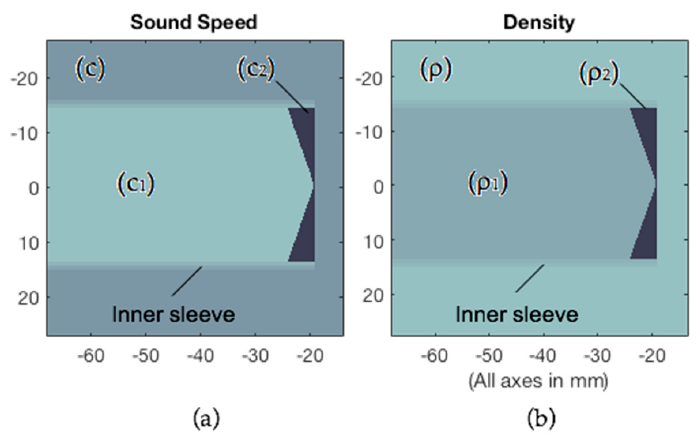
Figure A1. ( a ) Sound speed mask for the di ff erent mediums; ( b ) density mask for the di ff erent mediums. The computed focal length (F) and optimum stand-o ff ( δ ) values for di ff erent lens angles ( φ ) of epoxy and PDMS axicon, with a transducer near-field distance in the water of 68.2 mm, are shown in